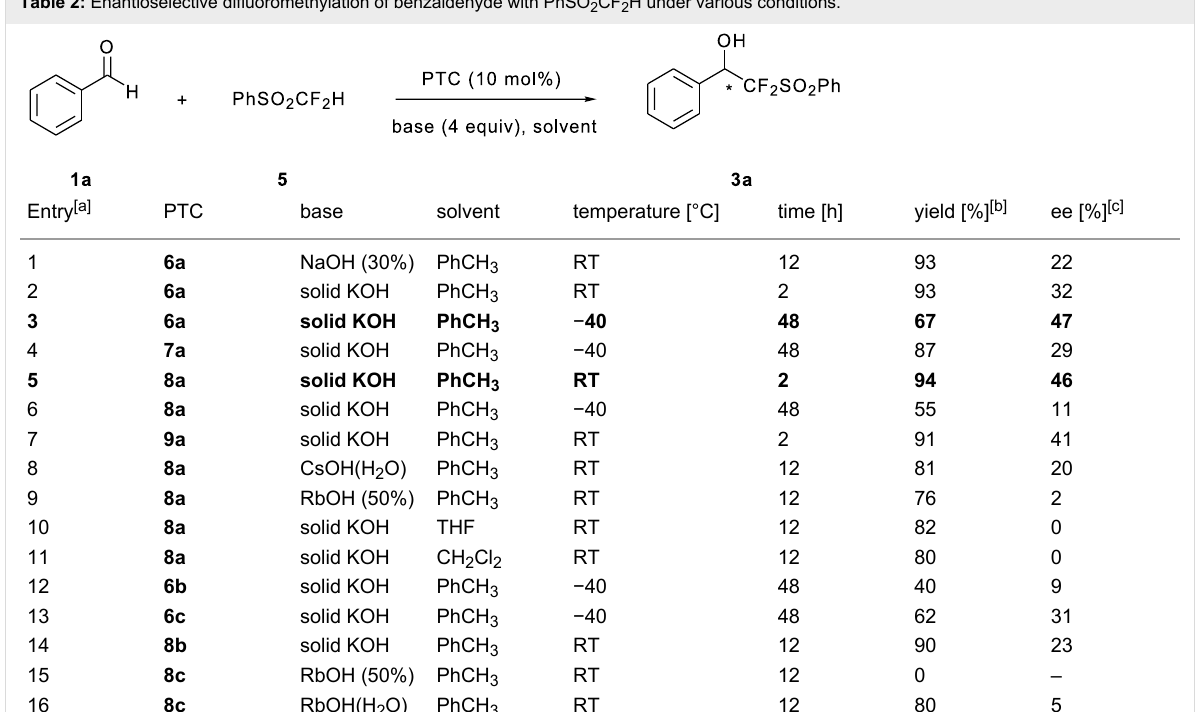
Table 2: Enantioselective difluoromethylation of benzaldehyde with PhSO 2 CF 2 H under various